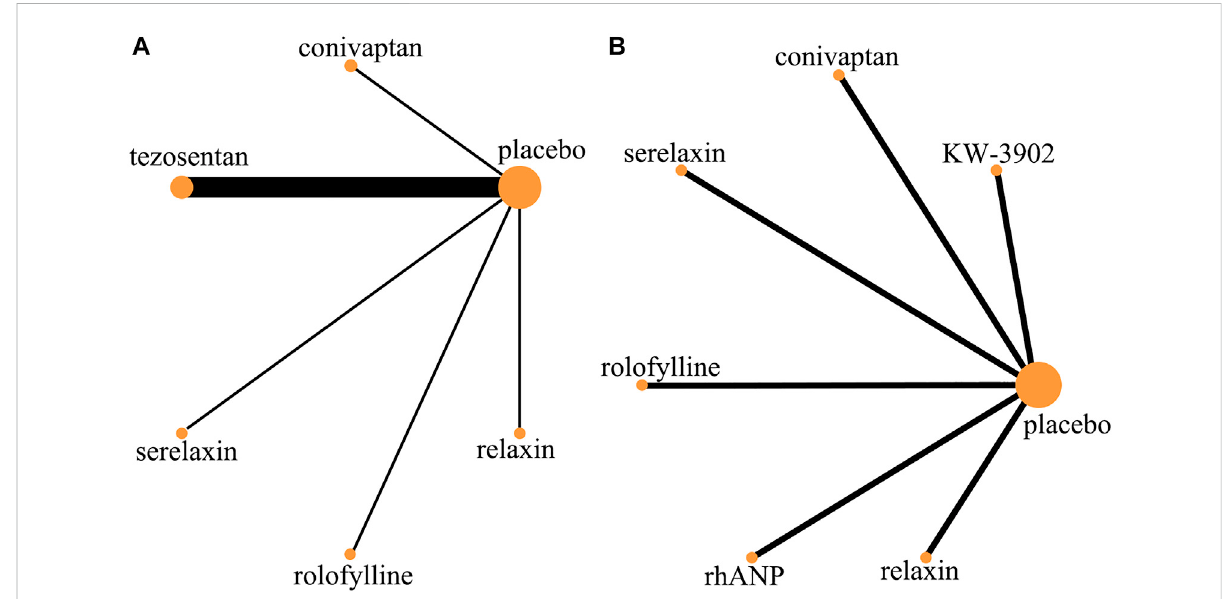
FIGURE 3 Evidence network (adverse event). (A) Rate of adverse event; (B) rate of serious adverse event.